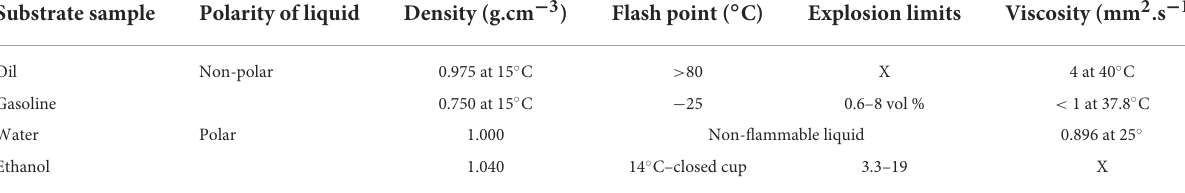
TABLE 2 Description of substances chosen as adsorption substrates